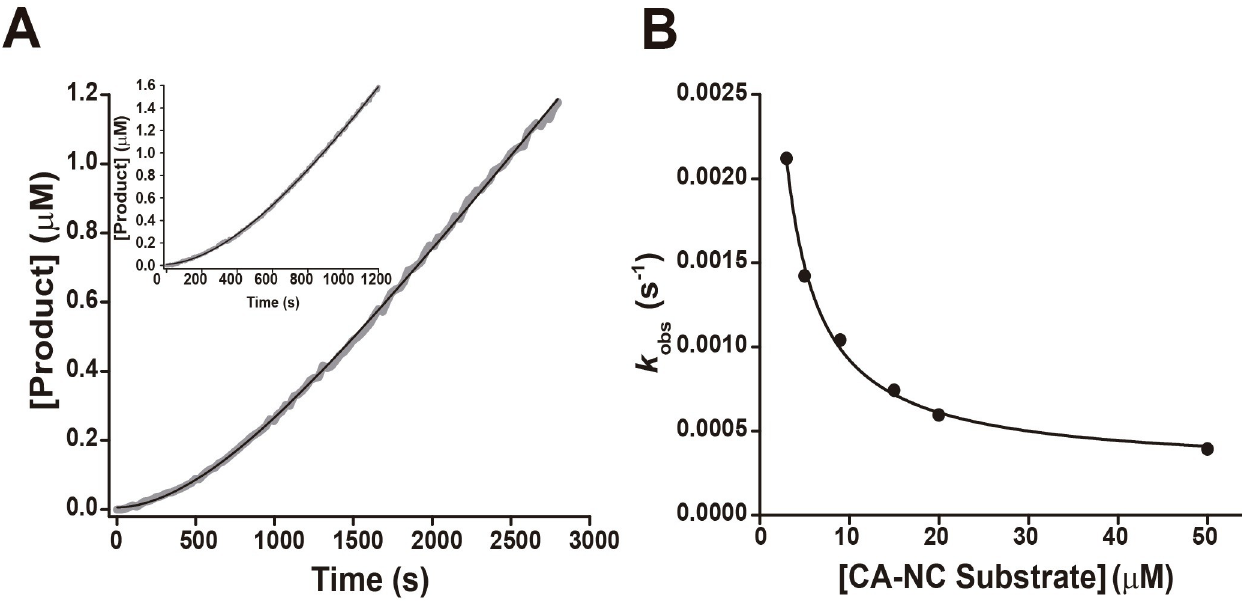
Fig 4. Kinetics of product formation of BLV-PR. (A) Progress curves for a representative experiment. The enzyme (5 nM, final concentration after 4-fold dilution) was added to reaction mixtures containing CA-NC substrate (5 μ M) in buffer reaction, at 37˚C. The black trace represents the best fit of Eq 2, from which the exponential rate constant k obs was obtained. The inset shows the progress curve when 5 μ l of concentrated PR (2.5 μ M) were added to 195 μ l reaction mixtures containing the CA-NC substrate (20 μ M) in the same buffer as in (A). (B) Dependence of k obs on the concentration of the CA-NC substrate (1– 50 μ M). The data points represent measurements in a representative experiment. The black trace represents the best fit of Eq 3 in agreement with Scheme 2.